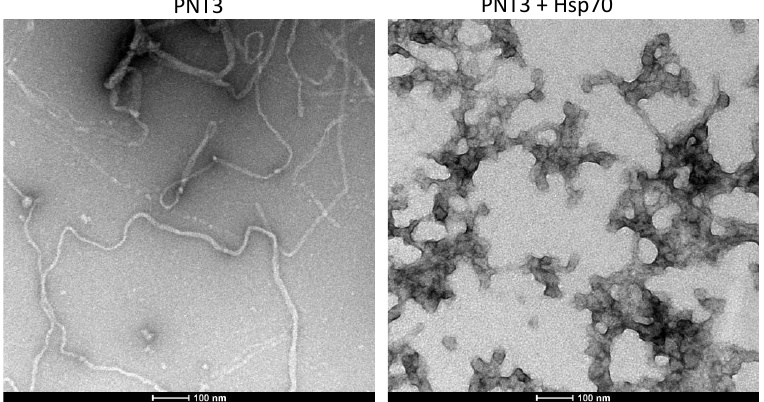
Figure 10. TEM micrographs of a PNT3 sample at 100 μM incubated at 37 °C for 27 h either in the absence or in the presence of a two-fold molar excess of Hsp70.